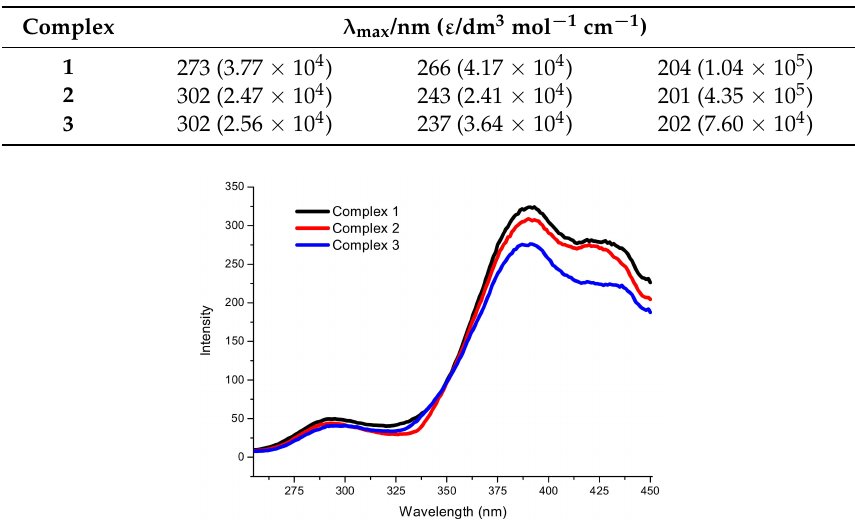
Table 3. UV-vis absorption spectral data for complexes 1 – 3 in methanol.